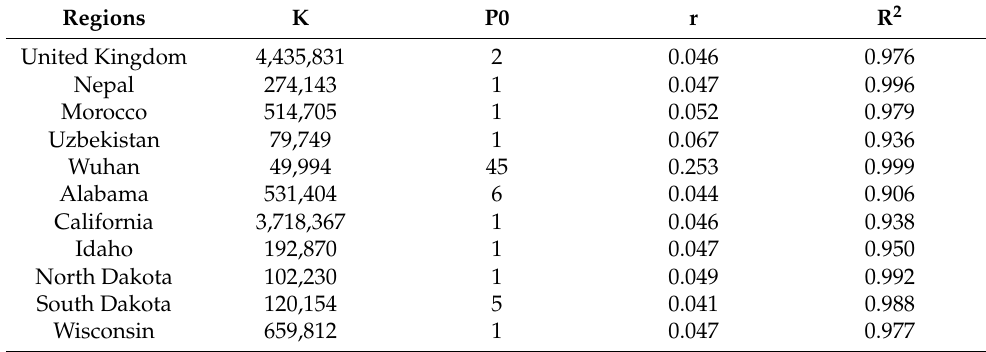
Figure 3. Figures ( a – r ) represents the fitting of cumulative confirmed cases of COVID-19 with the LgR model in different countries and regions. Table 2. LgR model parameters and goodness of fit for different countries and